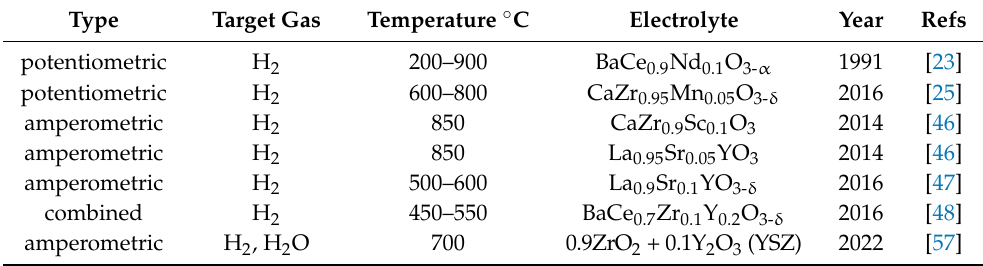
Table 2. Electrochemical gas sensors based on oxygen ion and proton-conducting solid electrolytes.